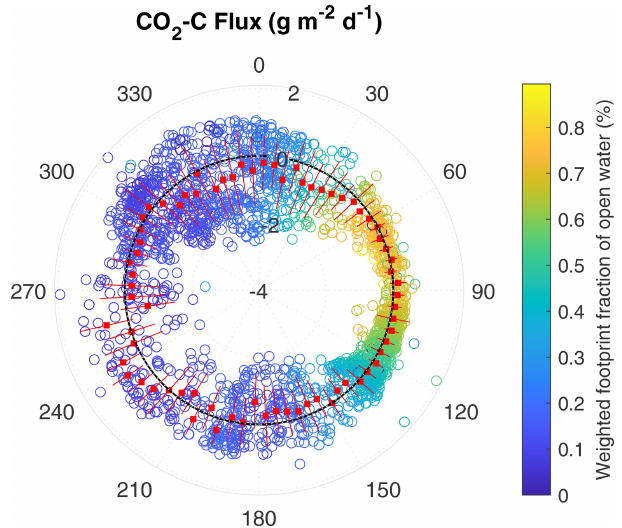
Figure 2. Polar plot of observed 30min CO 2 –C fluxes with respect to the wind direction. Negative values (inside of the dashed black line) represent CO 2 uptake, while positive values (outside of the dashed black line) represent CO 2 emissions. The values − 4, − 2, 0, and 2 indicate the magnitude of the CO 2 –C flux in gm − 2 d − 1 . The color of each point on the plot represents the percentage the point comprises of the total open-water weighted footprint fraction in each 30min flux. The red boxes indicate the mean CO 2 flux of 5 ◦ wind direction intervals during the 2-month observation period (red lines indicate the first standard deviation).